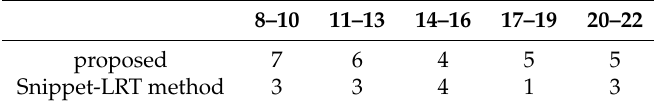
Table 1. The number of detected CEA in a day.